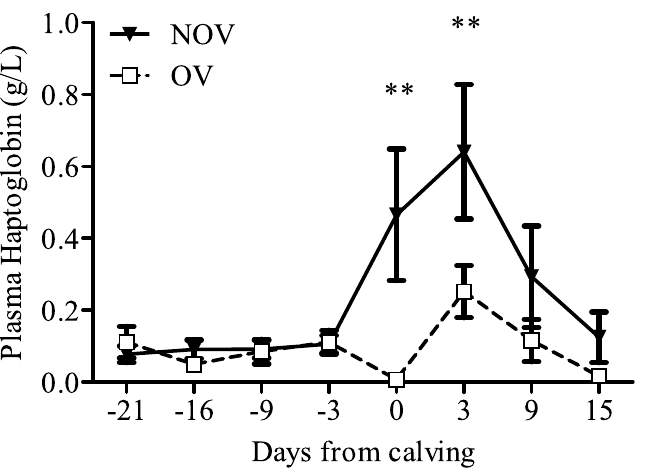
Fig 2. Plasma haptoglobin for ovulatory (OV) and non-ovulatory (NOV) cows. NOV cows have significantly higherlevels of haptoglobin compared with OV cows.